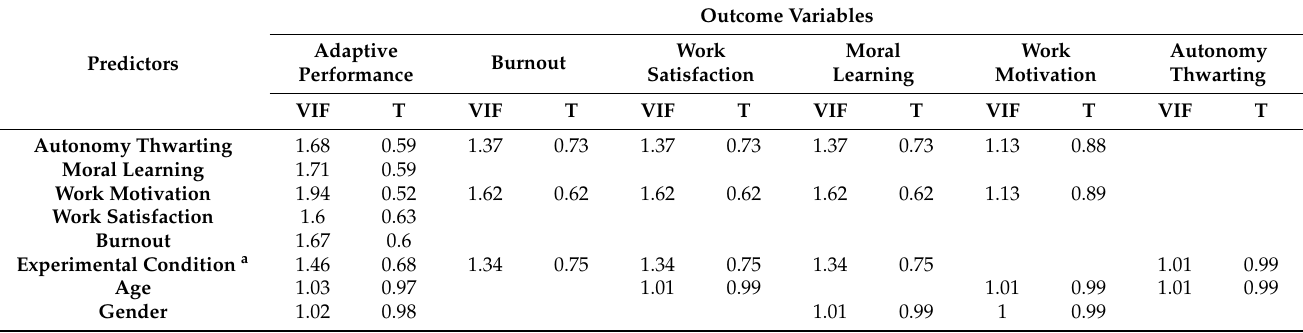
Table A1. Collinearity diagnostics.